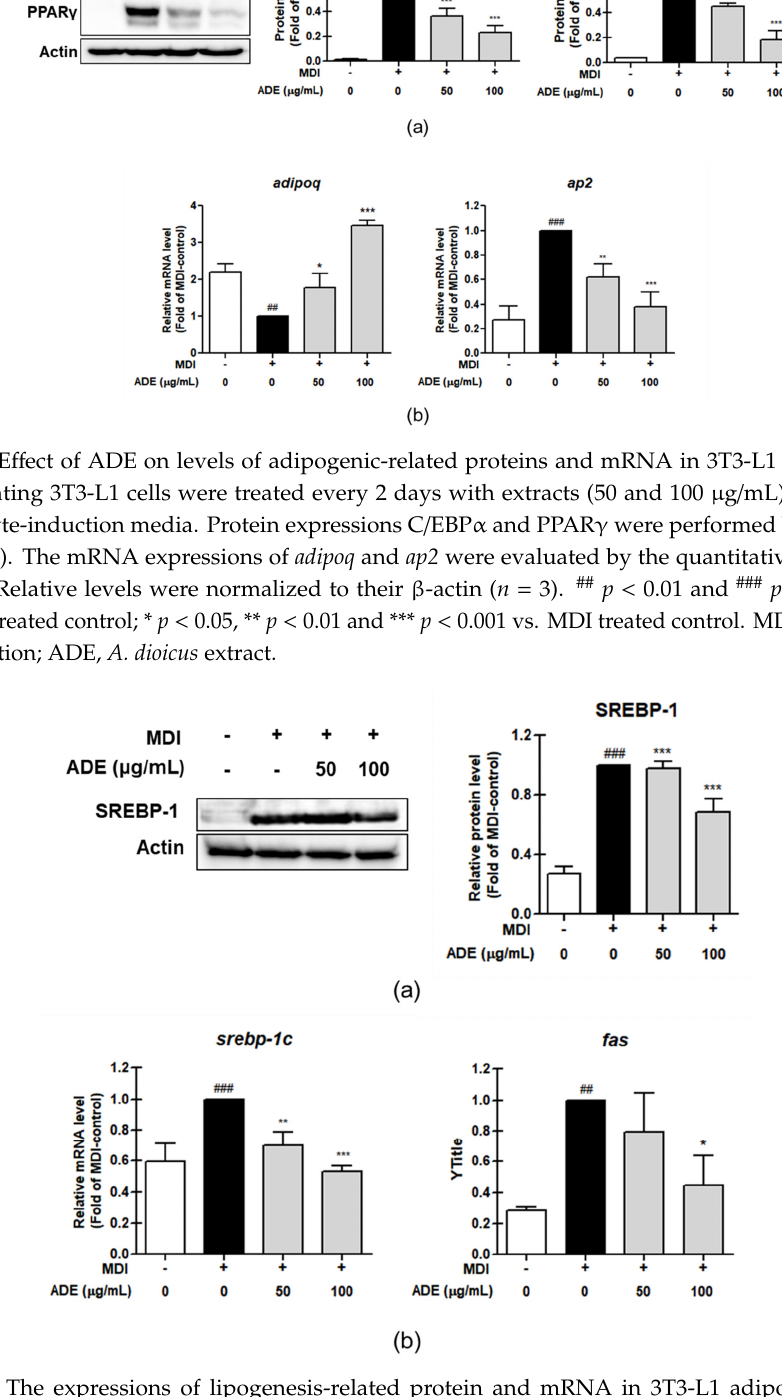
Figure 4. The expressions of lipogenesis-related protein and mRNA in 3T3-L1 adipocytes with ADE. Differentiating 3T3-L1 cells were treated with extracts (50 and 100 μ g/mL) for 8 days in adipocyte-induction media. Protein expressions SREBP1 was performed by Western blotting ( a ). The mRNA expressions of srebp-1c and fas were measured by the qPCR ( b ). Relative levels were normalized to their β -actin ( n = 3). ## p < 0.01 and ### p < 0.001 vs. non-MDI treated control; * p < 0.05, ** p < 0.01 and *** p < 0.001 vs. MDI treated control. MDI, media of differentiation; ADE, A. dioicus extract.